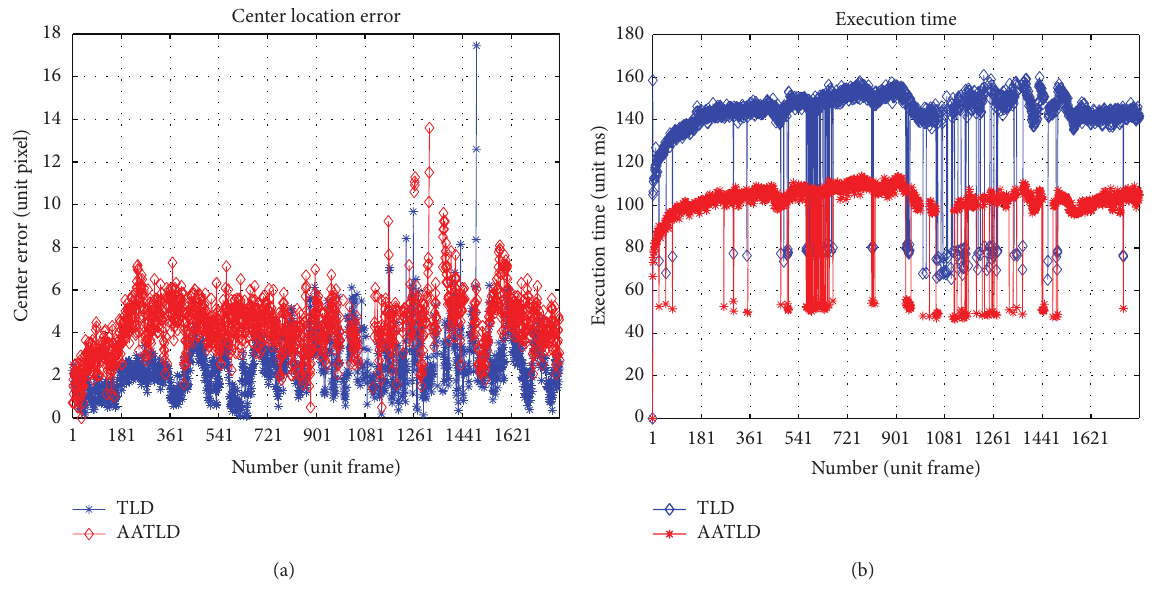
Figure 6: Performance contrast plots on center location and execution time of Shenzhou IX.